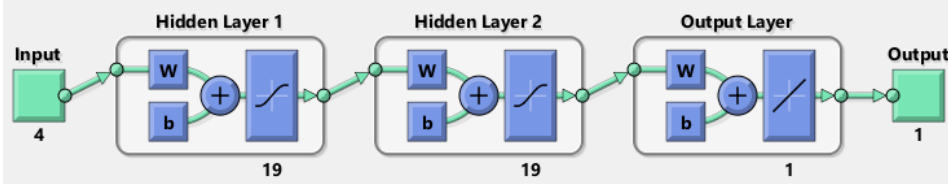
Figure 5. Search with Hill Climbing Random Restart and Tabu List algorithms of the minimum %RAE for the optimal ANN structure for the RW ( a ) and RW_WSB ( b ) exploration algorithms. By replicating the experiment in [16], the optimal structure obtained is presented in